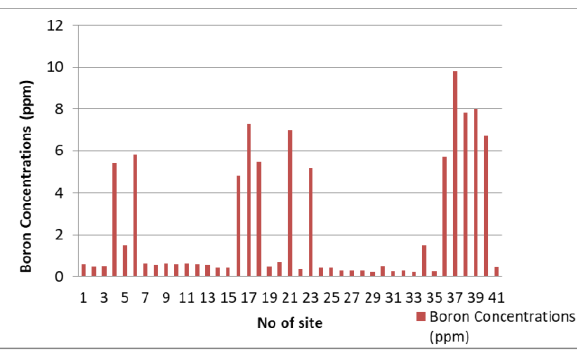
Fig. 5. Boron concentrations in Southern Basrah